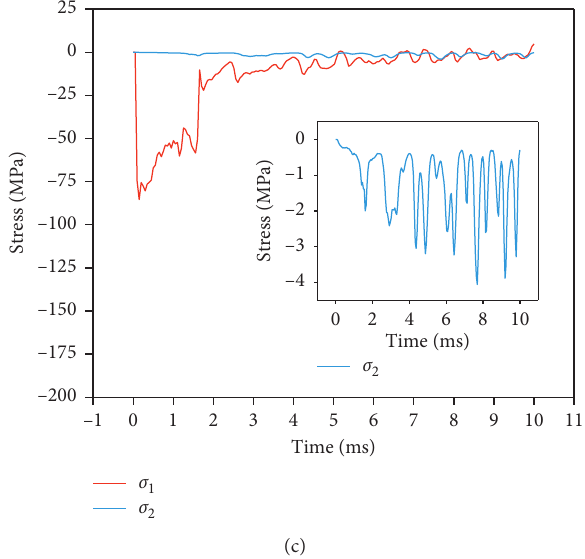
Figure 14: Stress-time curve of aluminum foam under different porosities. (a) 80%. (b) 85%. (c) 90%.